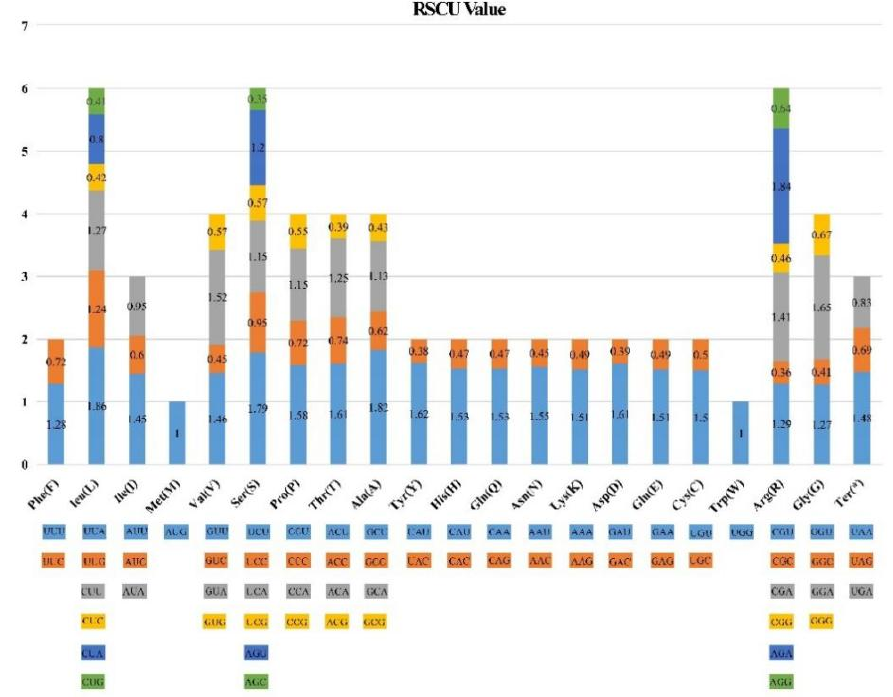
Figure 4. Relative synonymous codon usage (RSCU) value of 20 amino acid and stop codon of C. fargesii in protein-coding regions. The colors of the histograms are corresponding to the colors of codons.